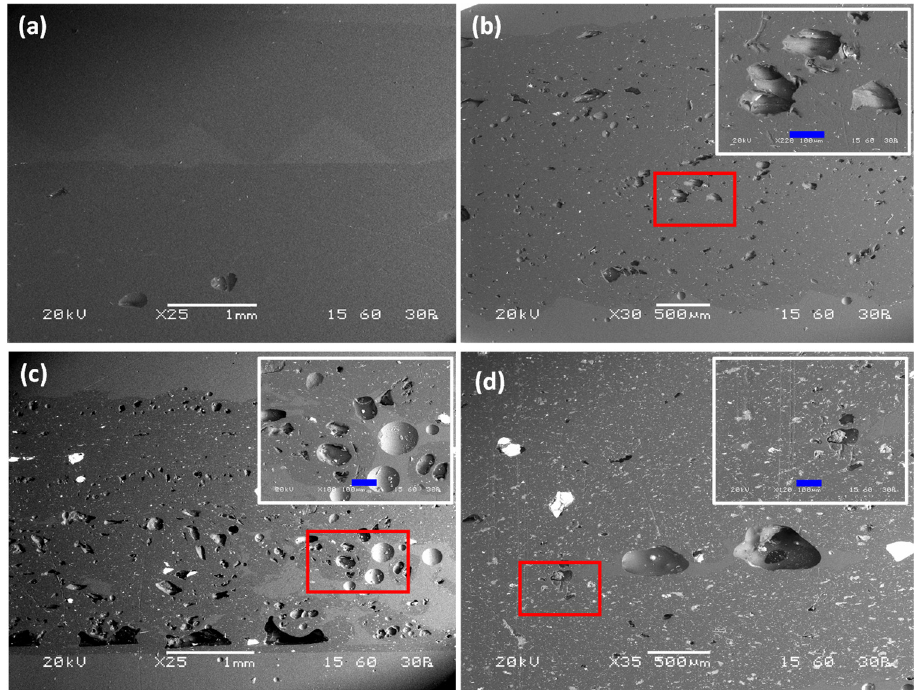
Figure 10. SEM of cross-sections of 3D printed dogbone samples constructed using: ( a ) neat ABS filament (×25), ( b ) composite filament with 10 vol.% of − 90 μ m microspheres (×30), ( c ) composite filament with 20 vol.% of 90–200 μ m microspheres (×25), and ( d ) composite filament with 20 vol.% of 200–350 μ m microspheres (×35). Detailed view of surface enclosed by the red rectangle is shown at the top left of ( b , c , d ) images. Length of blue bar is 100 μ m.